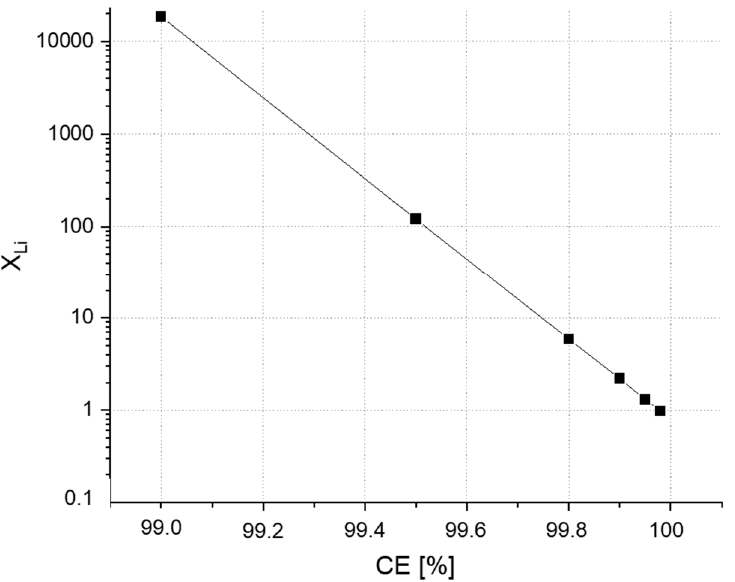
Figure 3. The need of total excess lithium at different CEs (vertical axis is in logarithmic scale).